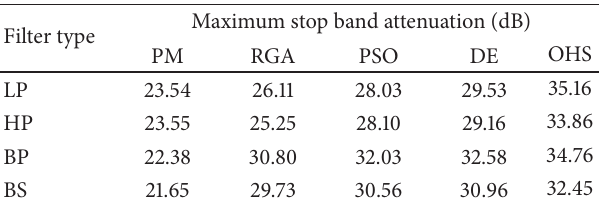
Table 6: Comparison of stop band attenuations for different types of FIR filters, each of order 20 using different algorithms.